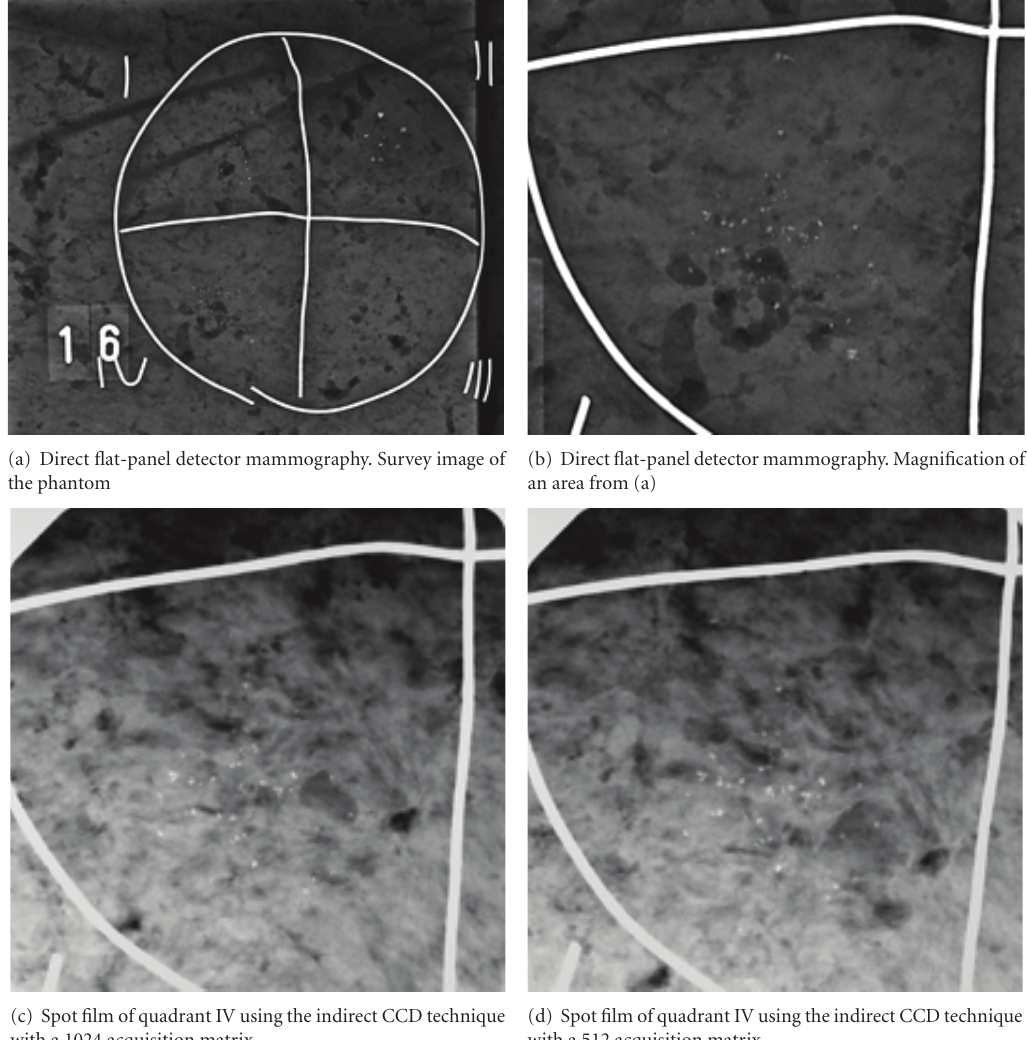
Figure 1: Radiological image of a laser-printer-film covered with di ff erent silica beads containing a polymethylmethacrylate (PMMA) sheet of 1.5-cm thickness (Plexiglas, Degussa) and a 1.5-com thick layer of ground meat as scattering bodies. For the raters’ orientation, a metal wire was used to divide the phantom into 4 quadrants. Direct flat-panel detector mammography scanned the whole phantom (a). The indirect CCD technique only produced spot images of the phantom’s 4 quadrants (c and d). Quadrant IV contains 49 lobular microcalcifications of 300–599 μ m in